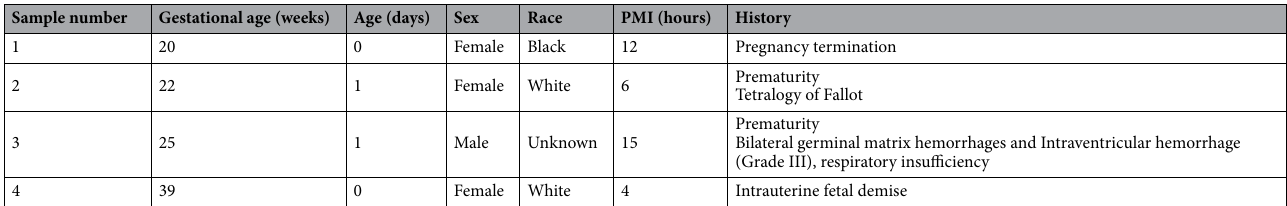
Table 1. Human fetal/infant liver tissue information. PMI, post-mortem